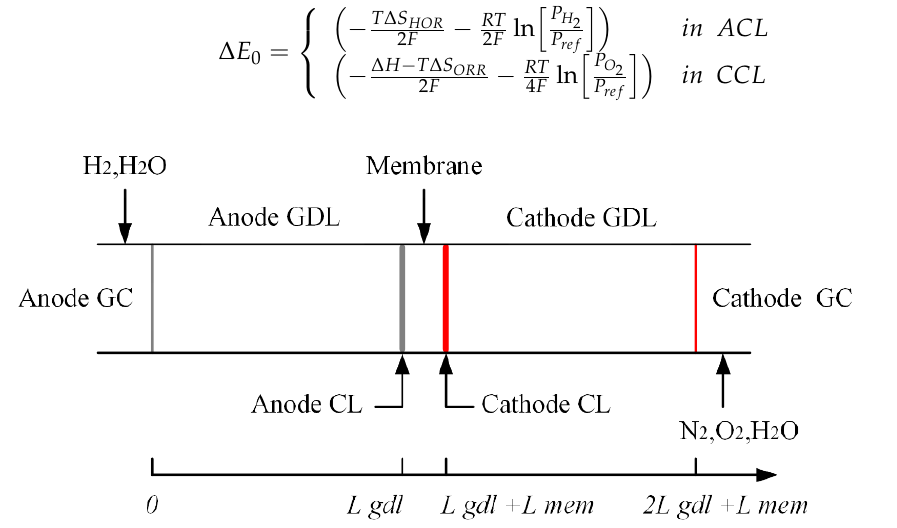
Figure 2. Schematic diagram of the 1-D model domains. The direction from the anode side to the cathode side is defined as a positive direction.